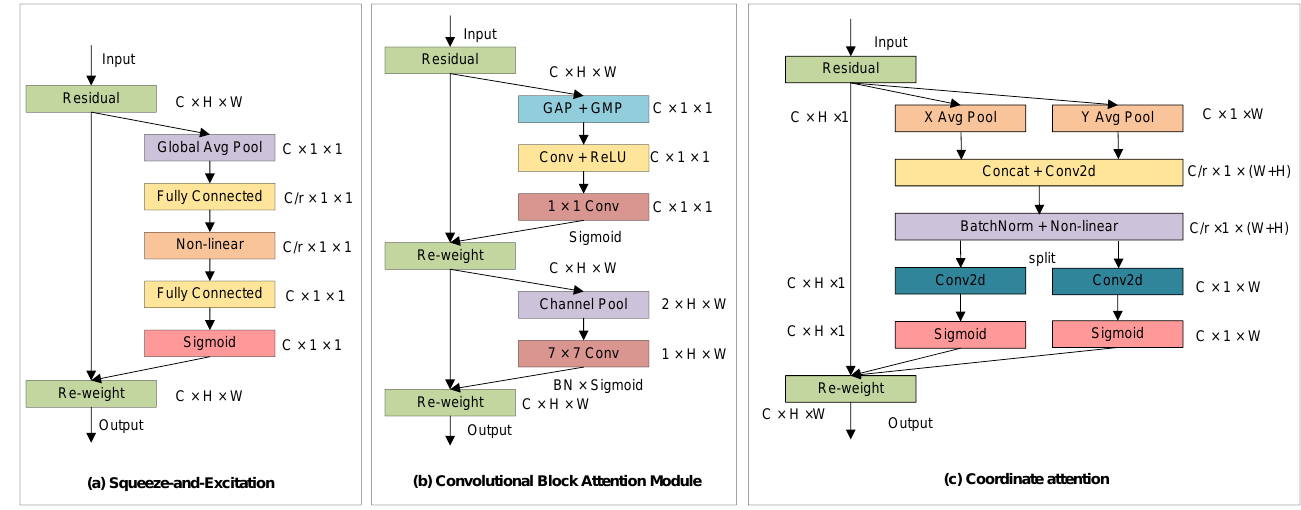
Figure 1. Attention mechanisms: ( a ) Squeeze-and-Excitation (SE); ( b ) Convolutional Block Attention Module (CBAM); ( c ) Coordinate Attention (CA).